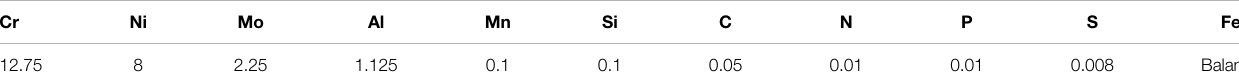
TABLE 1 | Nominal composition of UNS S13800.